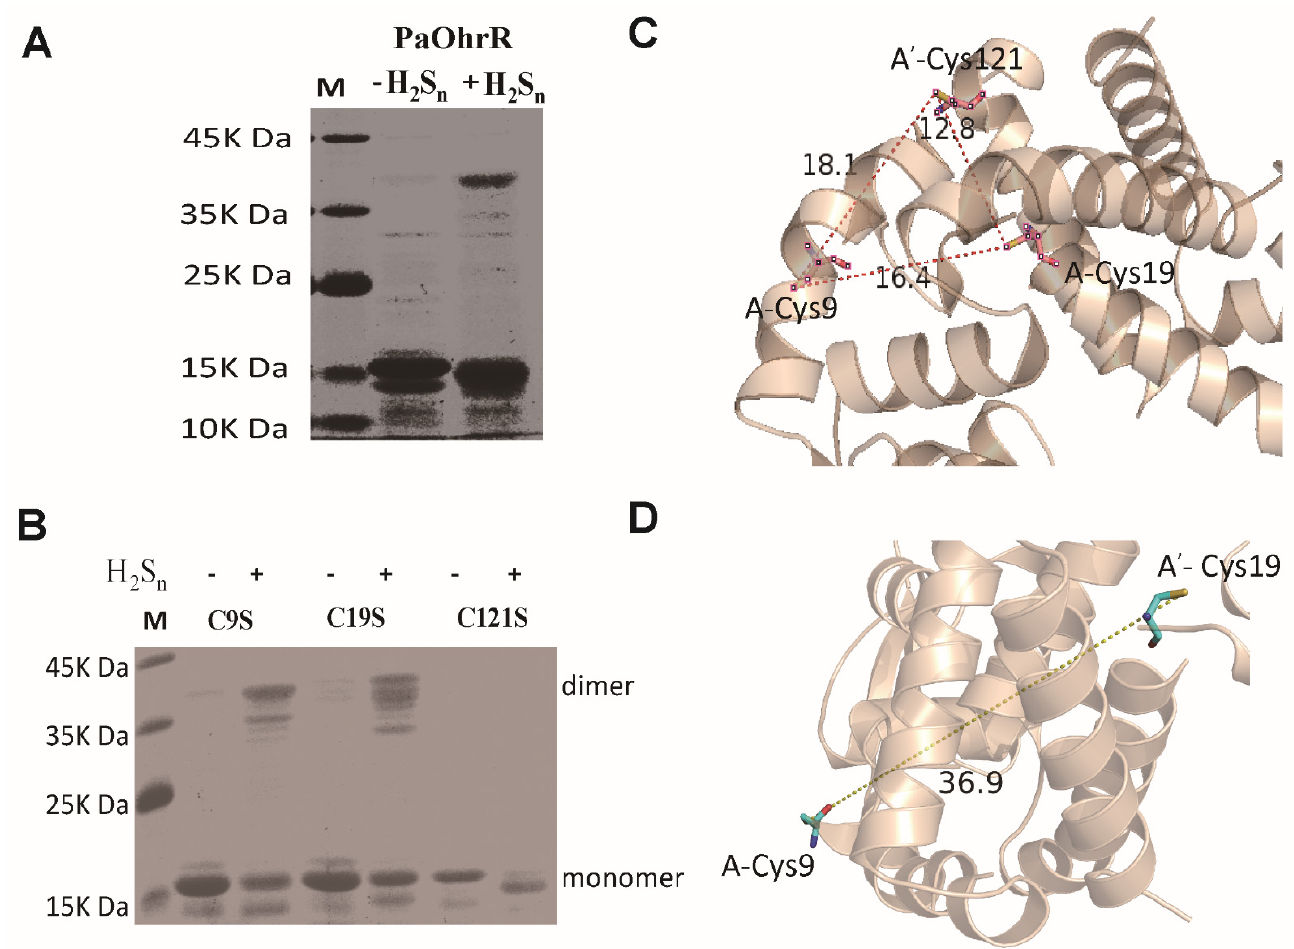
Figure 3. Three cysteine residues of PaOhrR were involved in disulfide formation. ( A , B ) Non-reducing, denaturing SDS-PAGE analysis of H 2 S n -treated and untreated PaOhrR and its mutants PaOhrR-C9S, PaOhrR-C19S, and PaOhrR-C121S. PaOhrR (25 μ M) and its mutants were purified and treated with H 2 S n (400 μ M) for 20 min and terminated by adding 500 μ M iodoacetamide to block free thiols. ( C , D ) The 3D structures were modeled by using the SWISS-MODEL method and the X. campestris OhrR structure (PDB ID: 2pex) as the template. The distances between the sulfur atoms of the cysteine residues were measured by using PyMOL (v1.5). A and A (cid:48) are used to distinguish different monomers in the PaOhrR